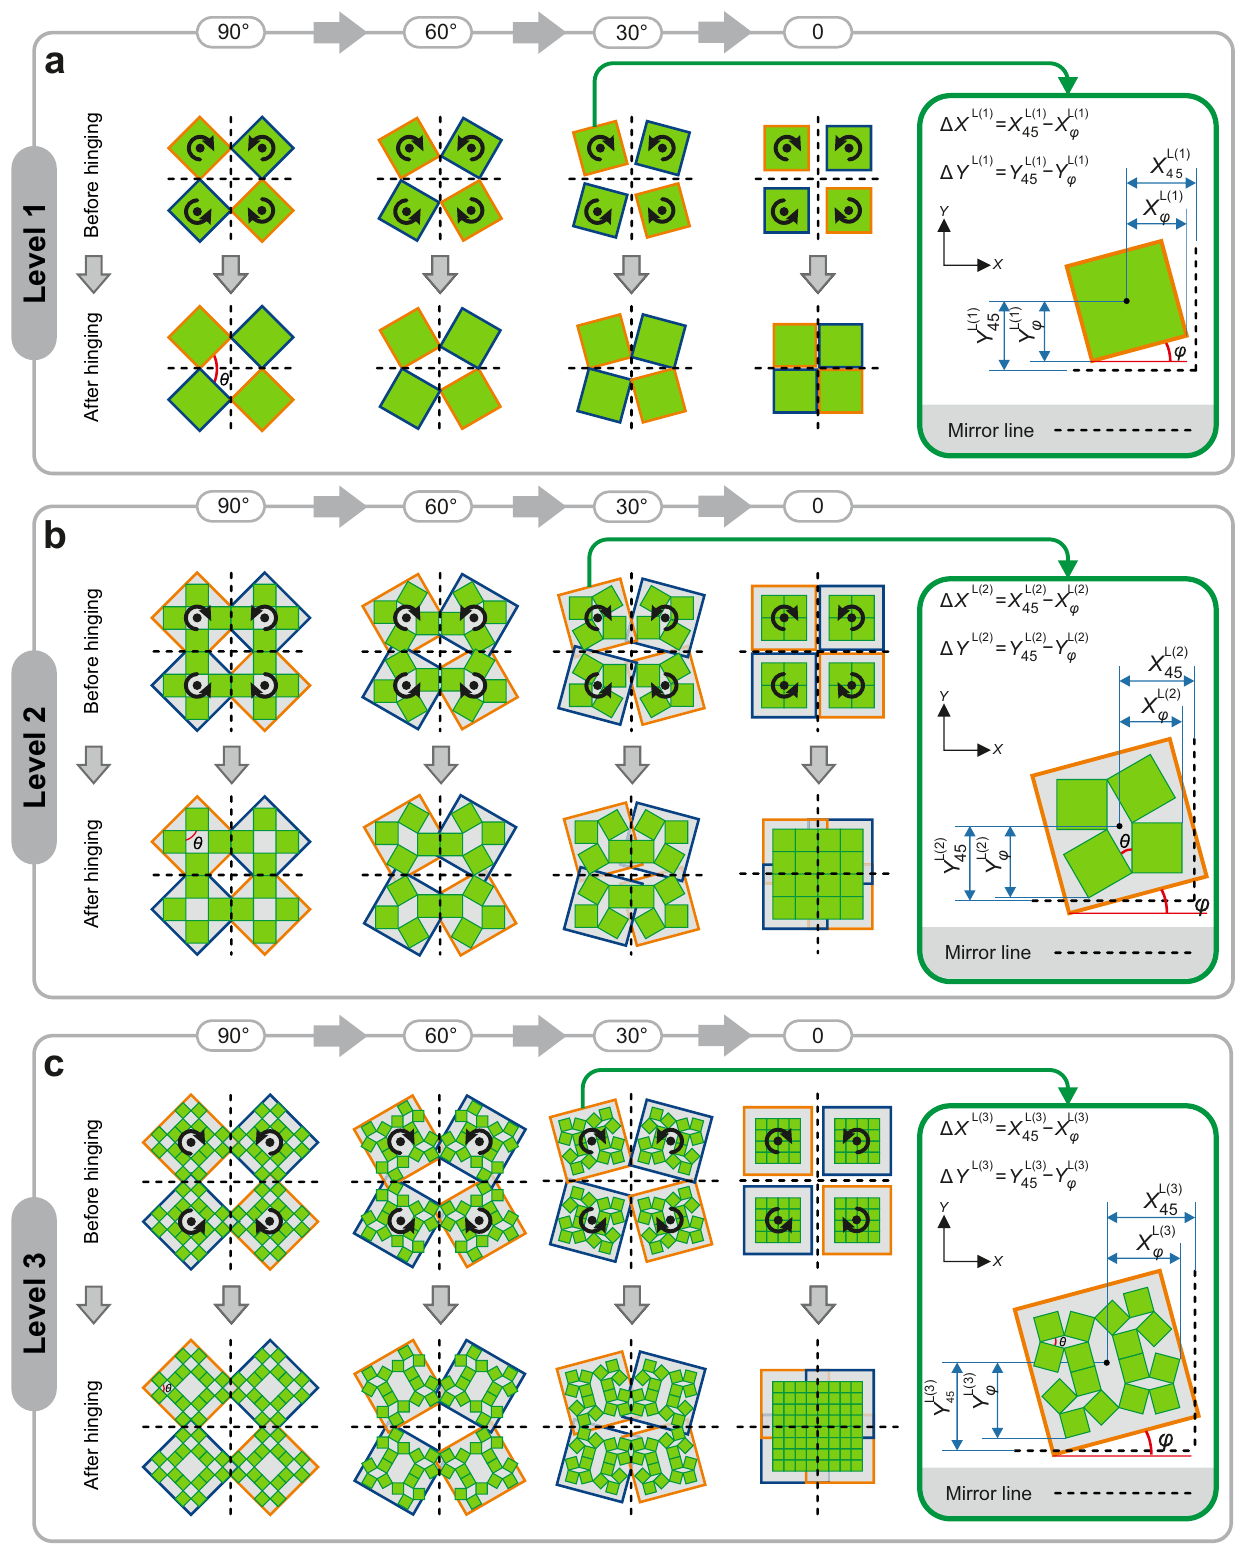
Fig. 5 The method of hinging in HiElm. a – c Depict the hinging method at levels 1, 2, and 3, respectively. On the right-hand side of each part (corresponding to each level), it is shown how Δ X L ð N Þ and Δ Y L ð N Þ are calculated during deformation, where φ is the rotation angle of respective parent (grey) squares, and dashed lines represent mirror